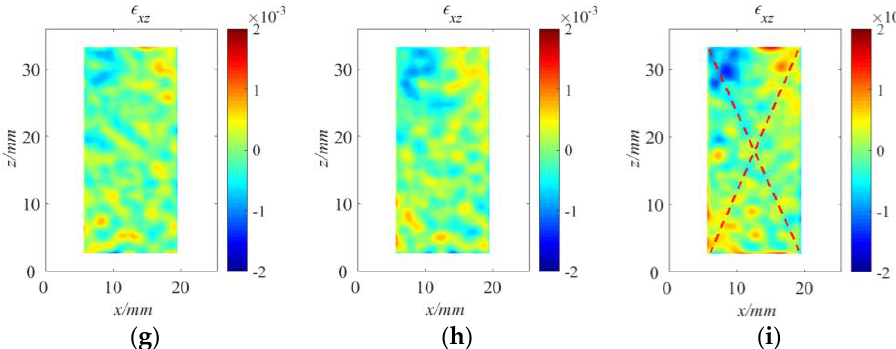
Figure 7. Contour plots of ε xz strain fields of the sectional images in step 4, step 5 and step 6. ( a – c ) along y = 6.20 mm, respectively; ( d – f ) along y = 12.50 mm, respectively; ( g – i ) along y = 18.80 mm, respectively.